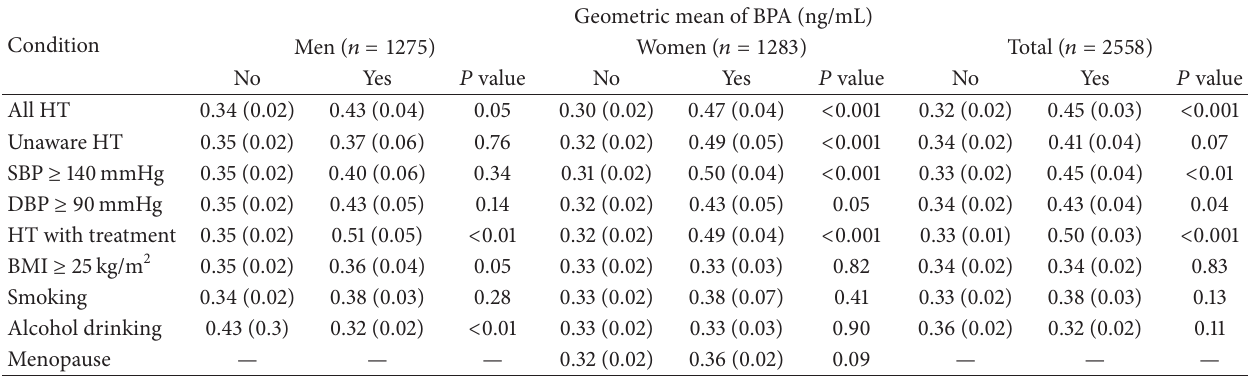
Table 2: Geographic mean (SE) of serum BPA by blood pressure status and selected factors among Thai men and